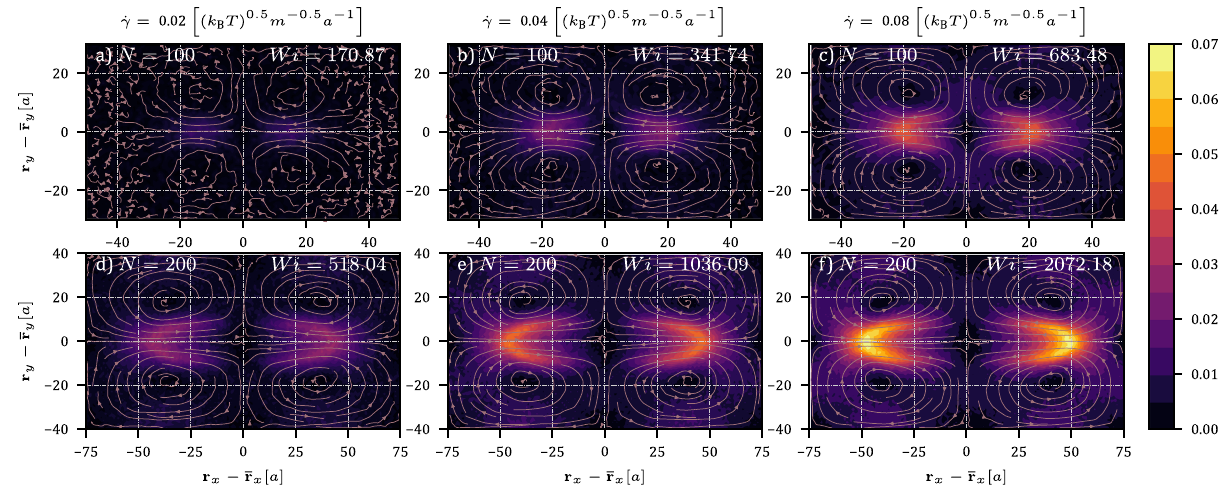
Fig. 3 Flow fi elds in the fl ow – vorticity plane centred around the centre of mass (cid:1) r of a 0 1 ring. The colour map encodes velocity magnitudes in units of ½ð k T Þ 0 : 5 m (cid:2) 0 : 5 (cid:6) . Left to right: increasing shear rates _ γ ¼ 0 : 02 ; 0 : 04 ; 0 : 08 ½ð k B Direct comparison between equal shear rates shows that back fl ow is signi fi cantly more pronounced at N =